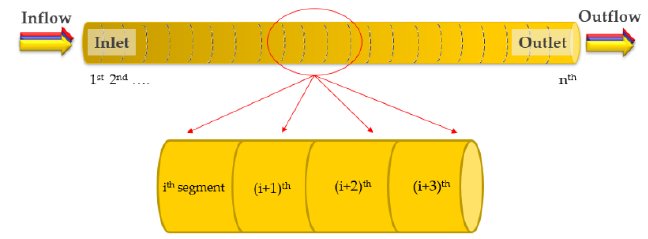
Figure 7. Schematic of a discretized pipe.